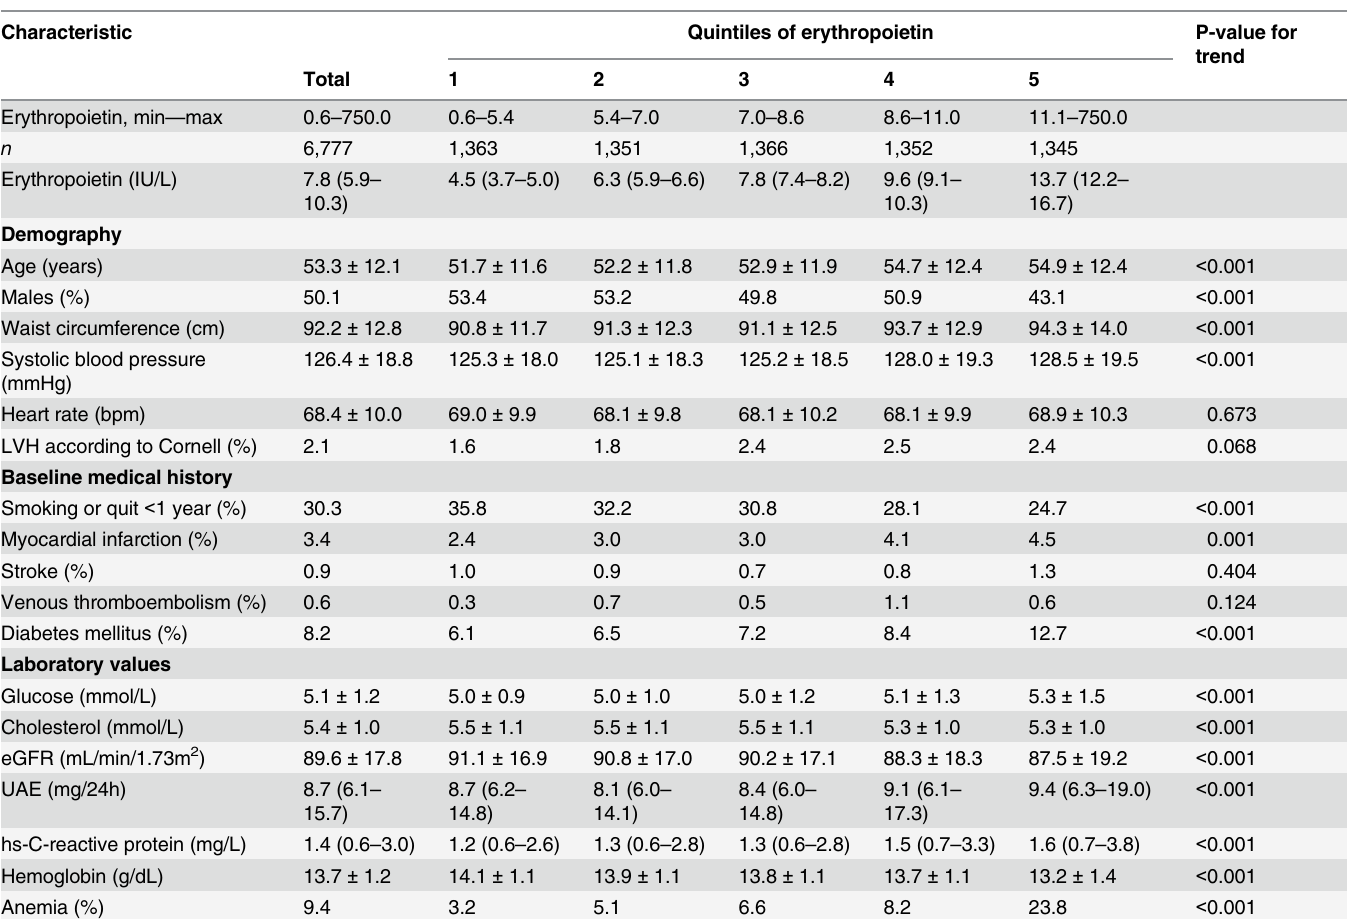
Table 1. Because of a significant interaction between hemoglobin and sex on EPO levels (p = 0.023), we additionally stratified baseline characteristics for sex, results are displayed in S1 and S2 Tables. Mean (± SD) age was 53.3 ± 12.1 years and approximately half (49.9%) of the pa- tients were women. Median (IQR) EPO levels were 7.6 IU/L (5.8 – 9.9) in men and 7.9 IU/L (6.0 – 10.6) in women, mean hemoglobin concentrations were 14.4 ± 1.0 g/dL and 13.0 ± 1.0 g/dL, re- spectively. Subjects in the upper EPO quintiles were older, had a larger waist circumference, higher blood pressure and were less often smokers. Furthermore, a history of myocardial infarction or di- abetes mellitus was more frequently observed with increasing EPO quintiles. Worse renal function and lower hemoglobin levels were observed in subjects with higher EPO levels; 13.1% of men and 33.9% of women in the highest EPO quintile were anemic. A total of 2,506 subjects passed the se- lection criteria for the reference set (see S3 Table for baseline characteristics of these subjects). Table 1. Baseline characteristics.